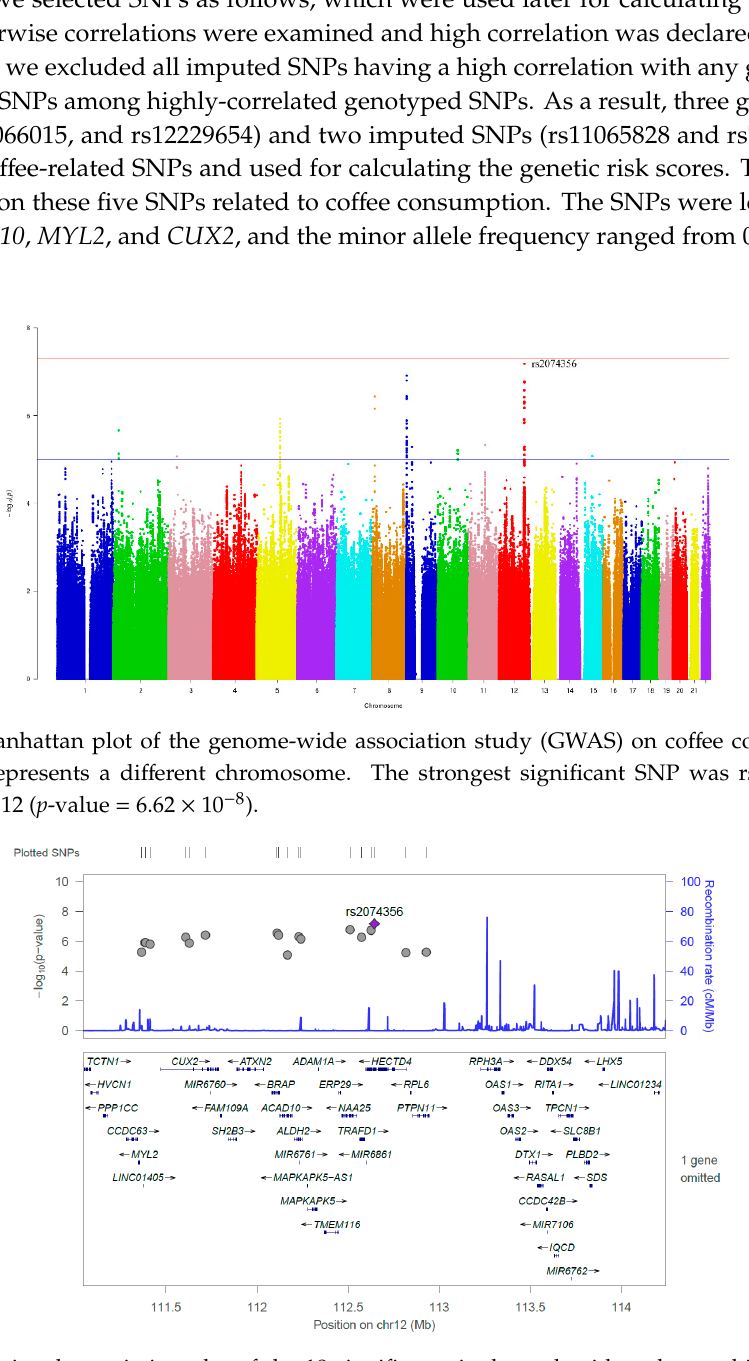
Figure 2. Regional association plot of the 18 significant single nucleotide polymorphisms (SNPs) discovered from the GWAS on coffee consumption. The strongest significant SNP, rs2074356, was shown in purple, and the gray dots represent chromosomal positions of other SNPs near the rs2074356.